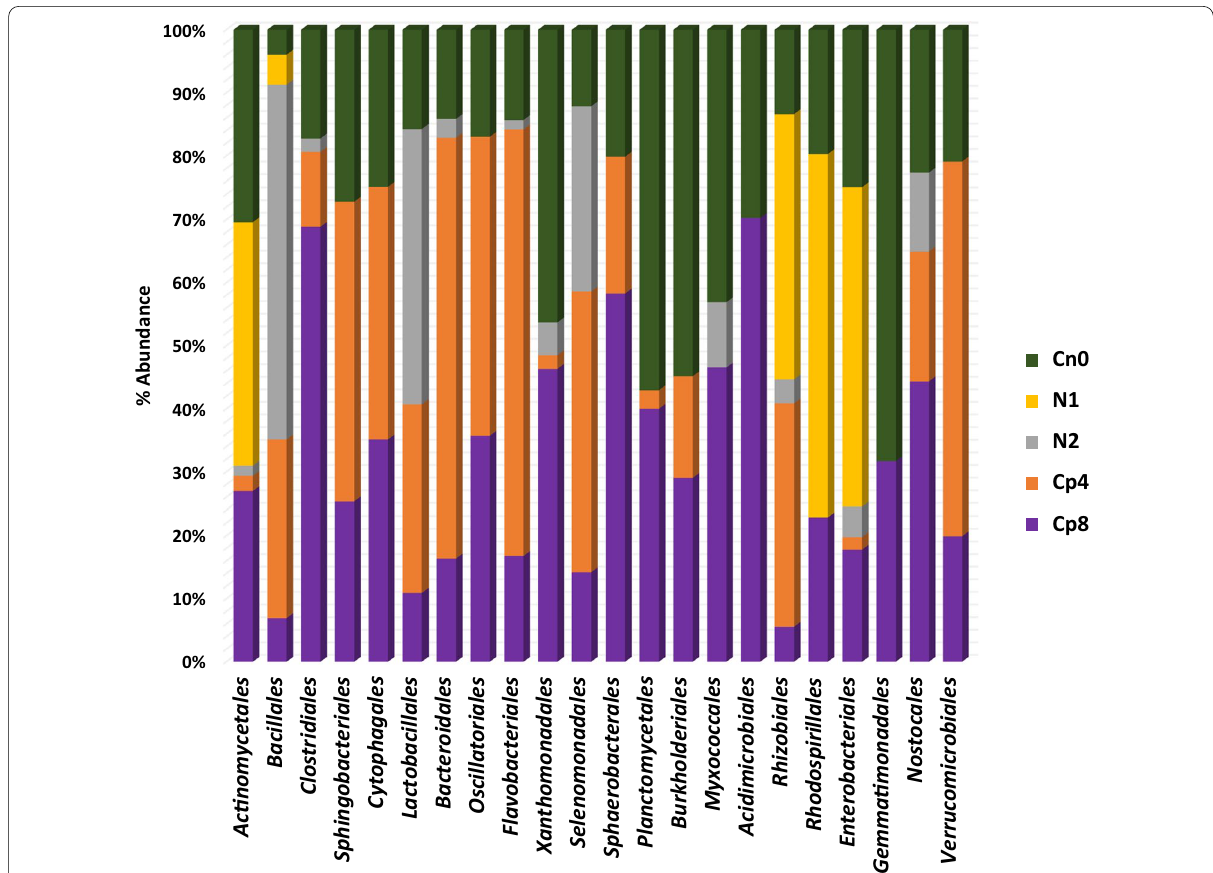
Fig. 2 Relative abundance of obvious bacteria order present in the rhizosphere soil treated